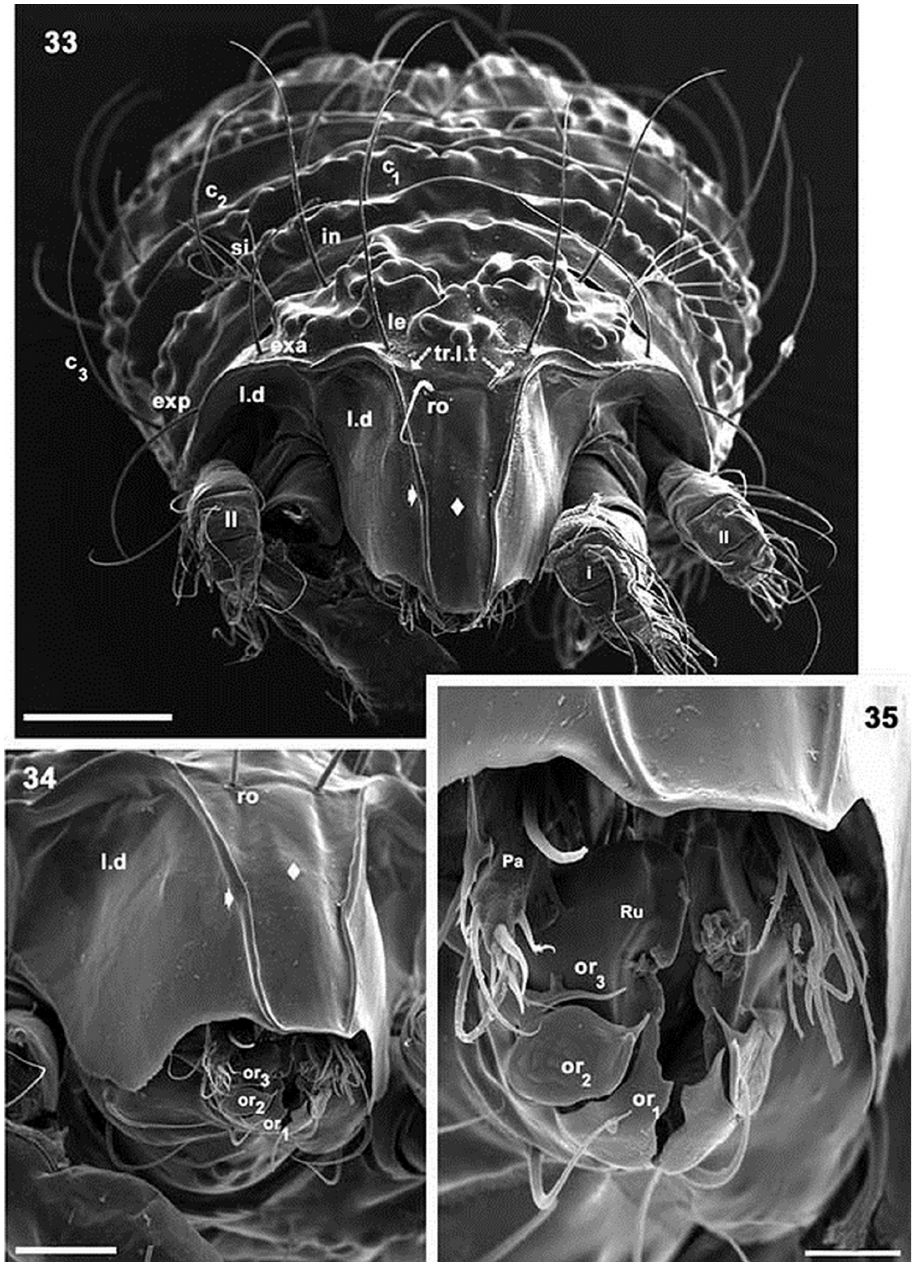
Figures 33–35. Paulianacarus costaricensis sp. n. Adult with cerotegumental layer. SEM. 33 frontal view 34 prodorsum, laterally inclined 35 apical zone, infracapitulum. Abbreviations: See Material and meth- ods. Scale bars: 33 = 100 μm ; 34 = 50 μm; 35 = 20